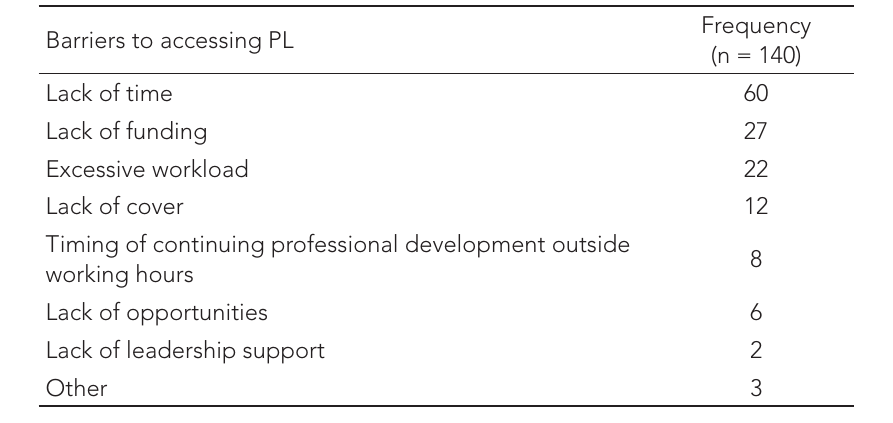
Table 5: Barriers to accessing PL mentioned across all four teacher surveys Barriers to accessing